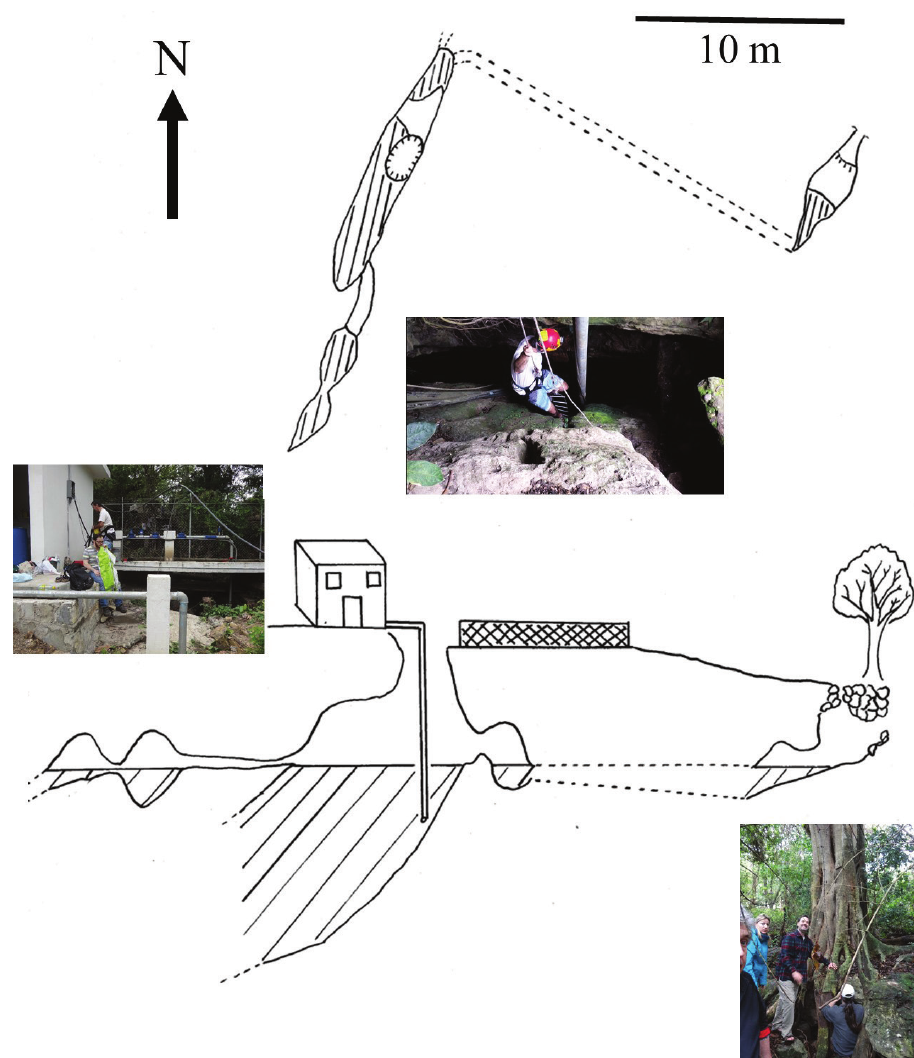
Figure 1. Chiquitita Cave map. The accessible and explored cave system is composed of a pit from which locals pump water out and a small chamber under the roots of a tree. Photographs from left to right are: 1 The pump facility with the pipe going into the pit 2 Descending into the pit 3 Entrance to the small chamber under the